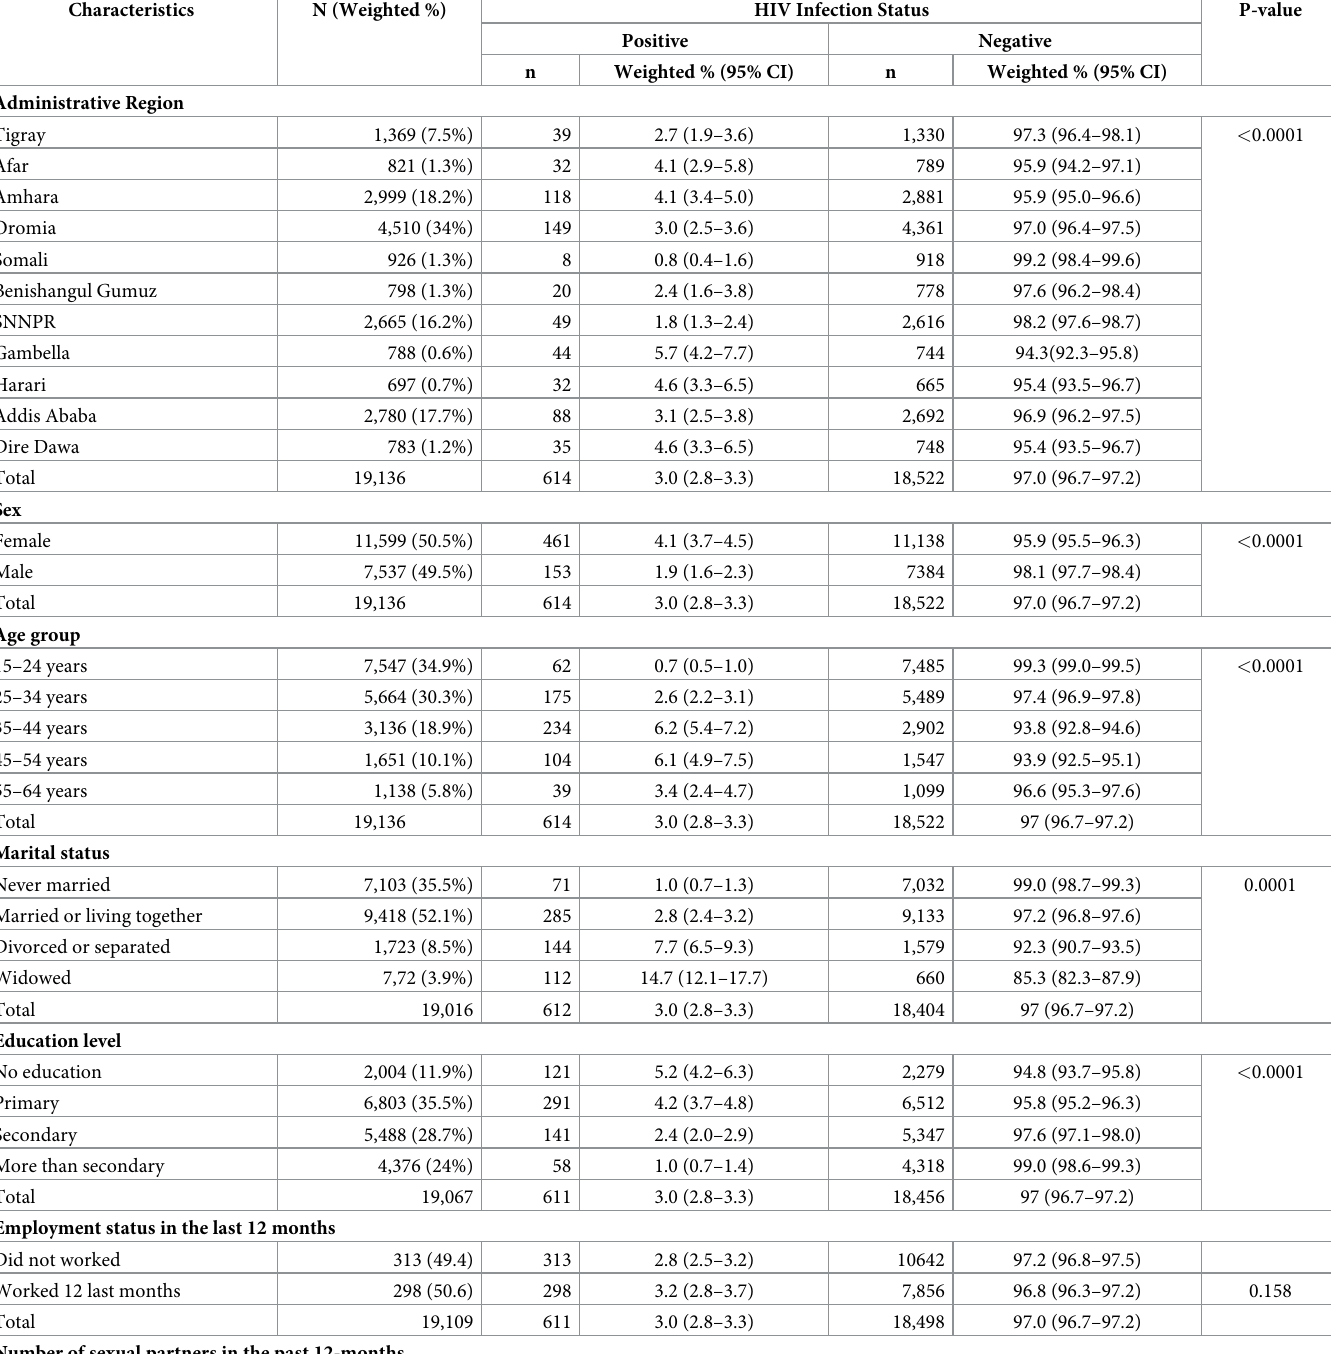
Table 1. HIV prevalence by socio-demographic and behavioural characteristics among participants aged 15–64 years, Ethiopia population-based HIV impact assessment, 2017–2018.